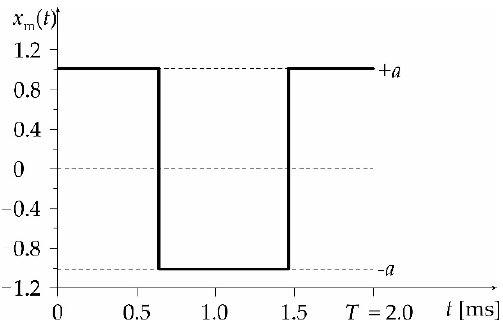
( t ) obtained for the considered Figure 8. Signal 𝑥 (cid:2923) (𝑡) obtained for the considered accelerometer. Figure 8. Signal x m